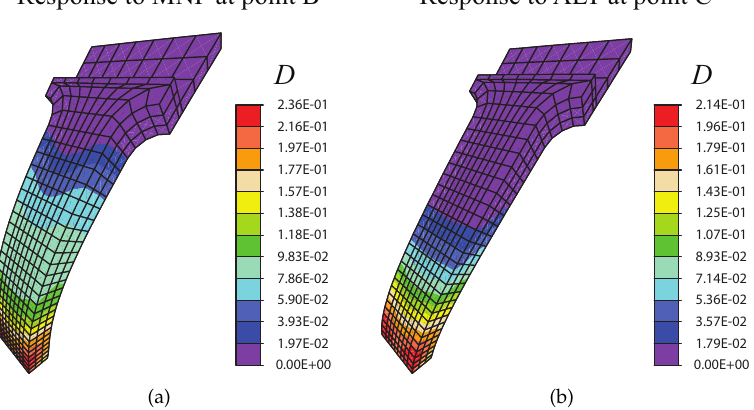
Figure 24. Distribution of the damage variable D on the pier deformed configurations corresponding to the responses to: ( a ) MNF at point B in Figure 13a, ( b ) ALT at point C in Figure